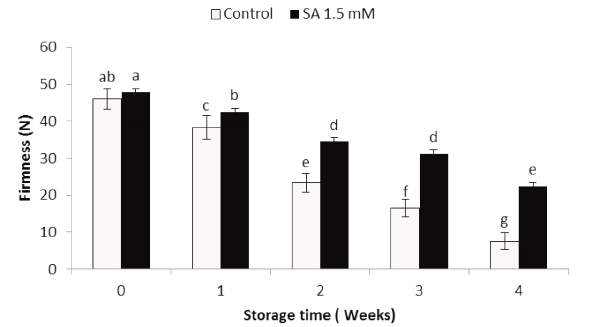
Fig. 2 - Firmness of peach fruits treated with preharvest SA at 1.5 mM stored at 1±0.5°C for up to 28 days. Data shown are mean ± standard deviation of three replicate (n = 3).